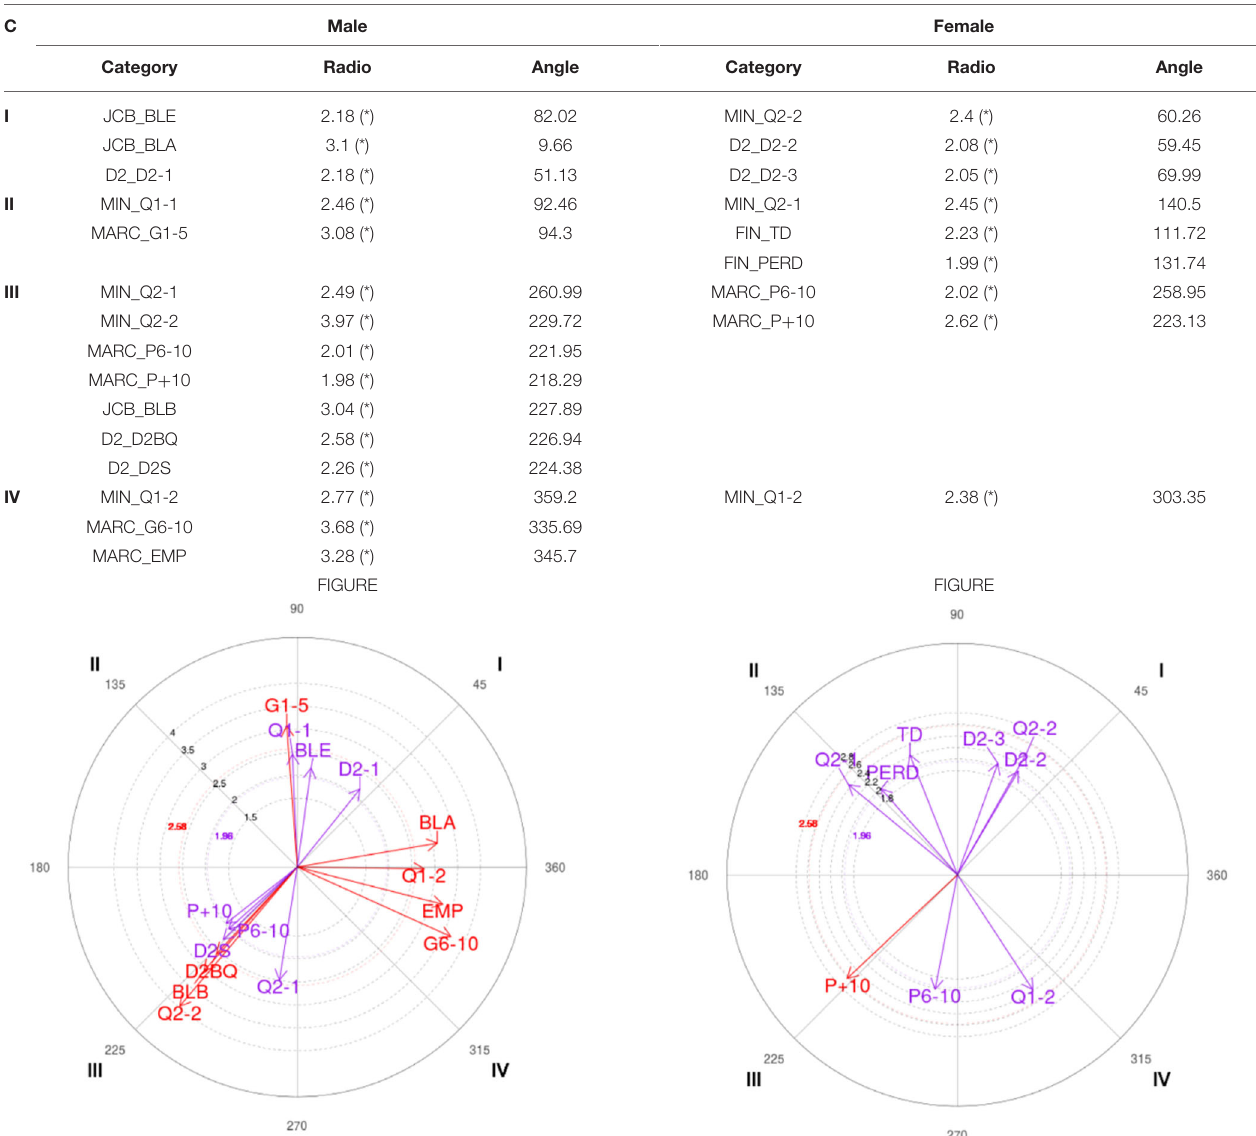
TABLE 5 | Significant relationships and vector representation between SCBQ focal behavior and mating behaviors for each gender.